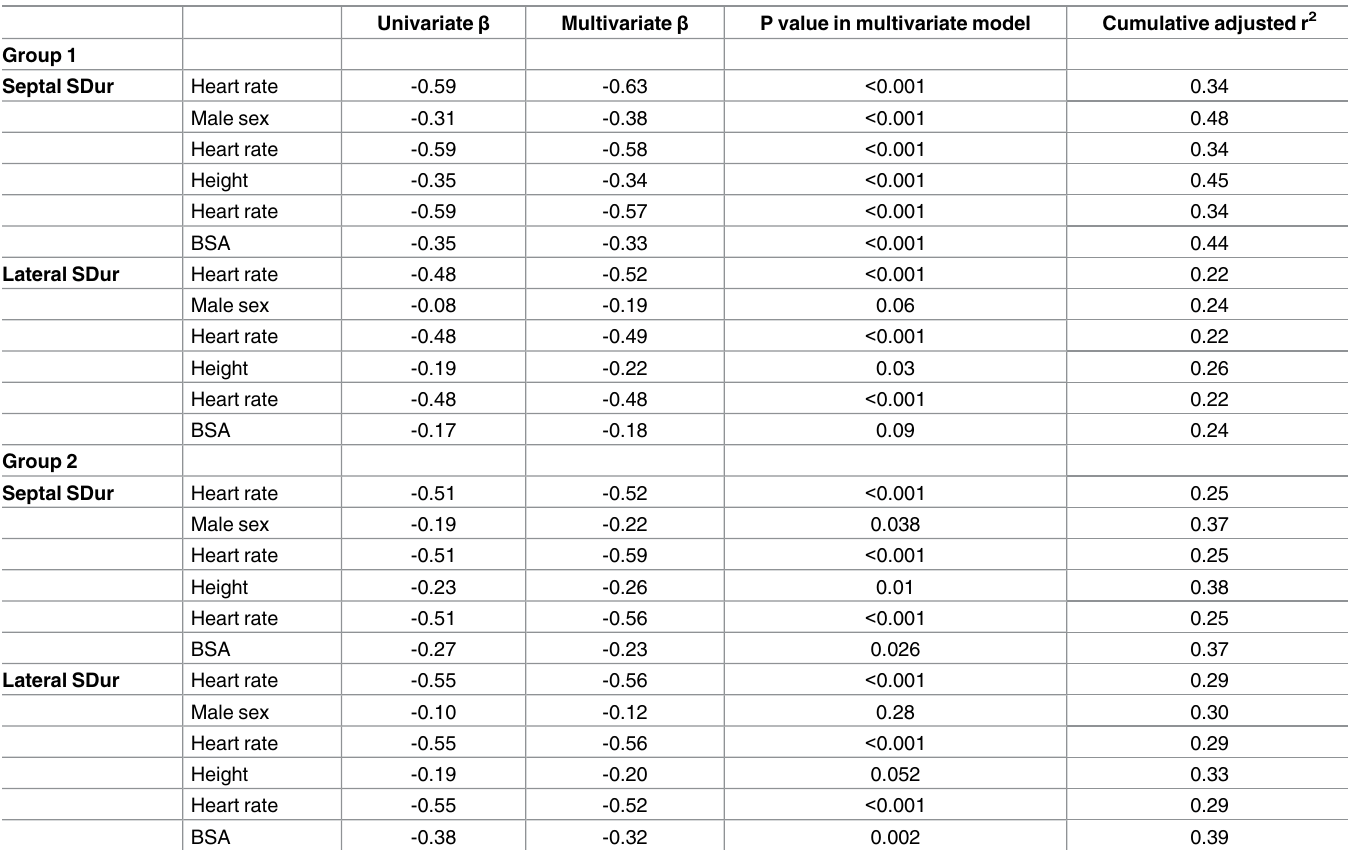
Table 5. Linear regression analysis of SDur with heart rate, sex and body size in Groups 1 and